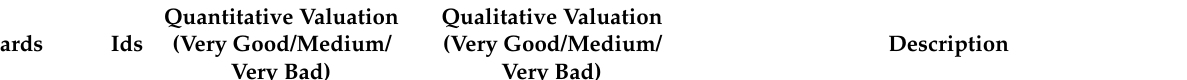
Table 3. Static-structural, atmospheric and anthropic hazards input variables